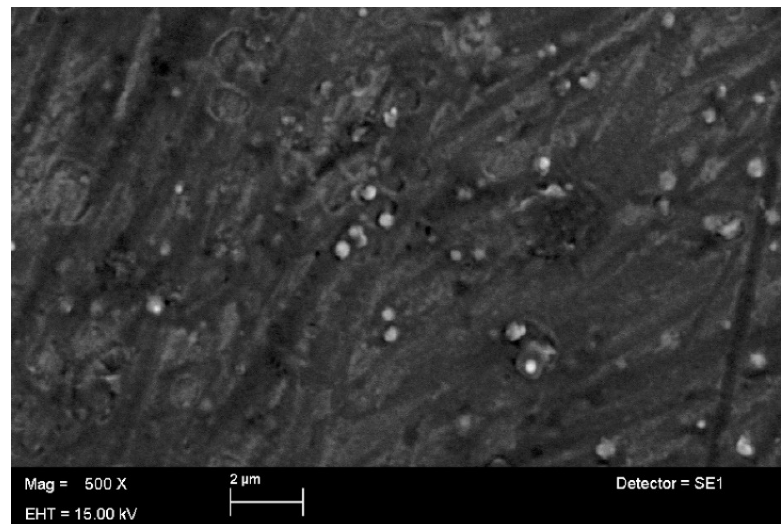
Figure 3. SEM images of optimized TBN-CSNP.